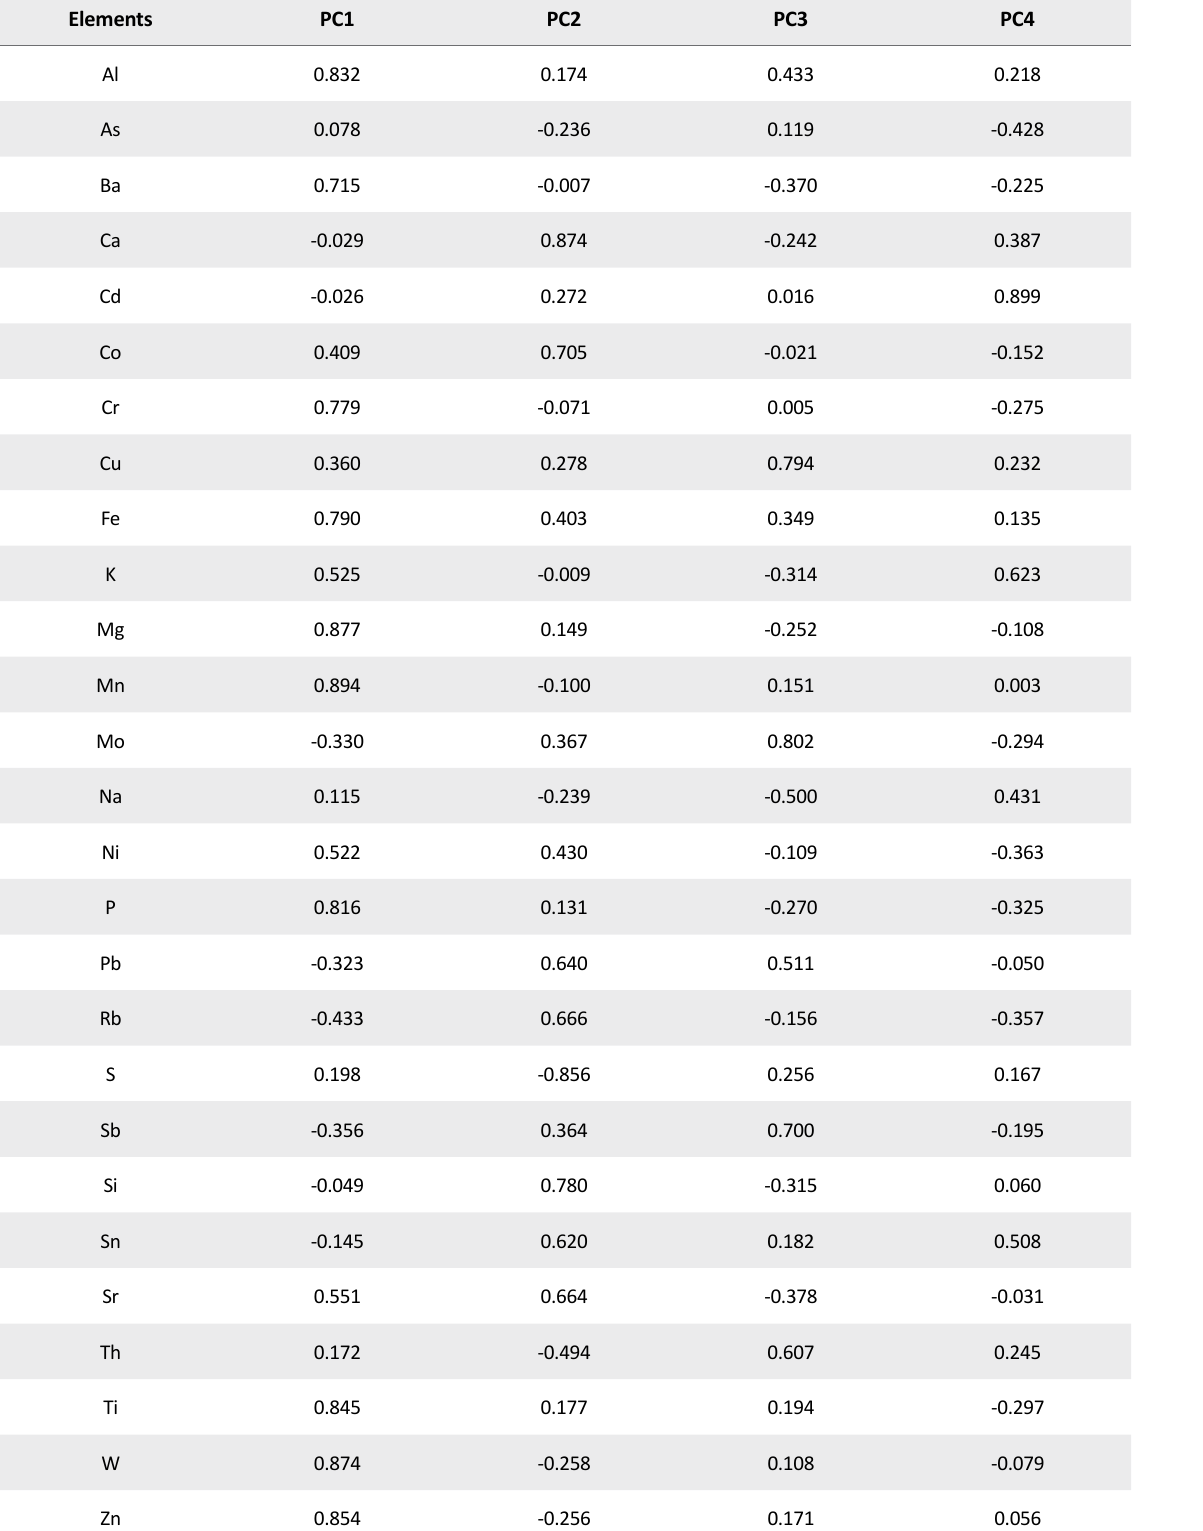
Table 5. Loaded characteristics for PC1, PC2, PC3, and PC4 resulting from PCA for elemental concentrations of the fish skin in three different stations of the Caspian Sea,